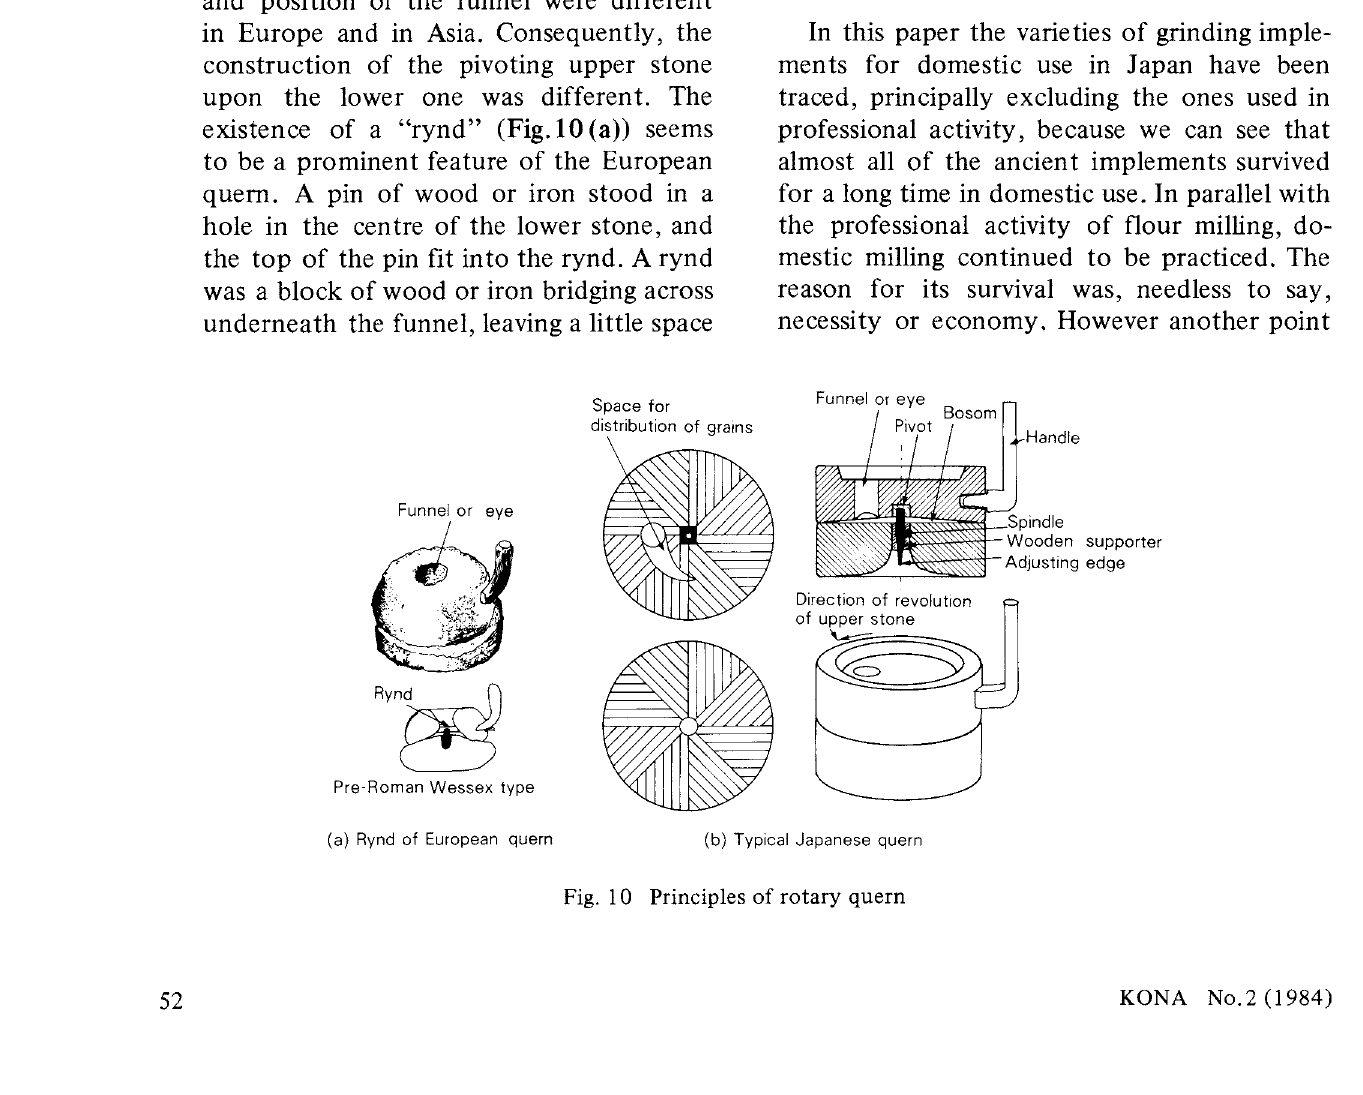
Fig. 1 0 Principles of rotary